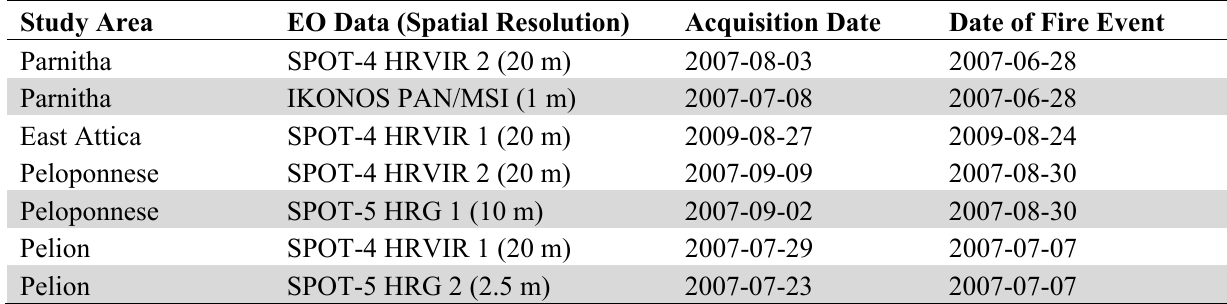
Table 1. List of available data. Data highlighted in grey are used for the accuracy